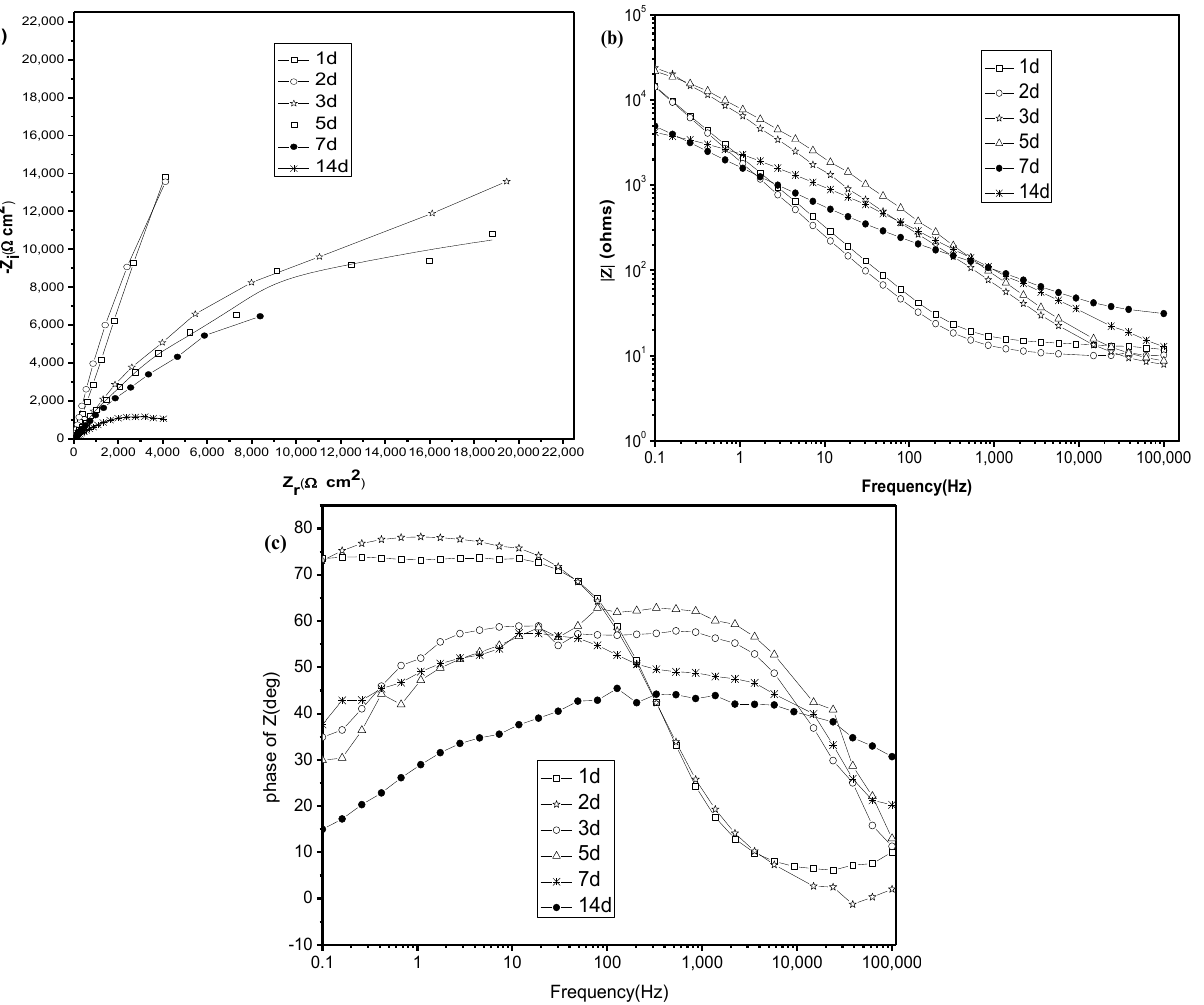
Figure 4. EIS of titanium immersed for different times in artificial saliva containing 5.0 g/L lactic acid. ( a ) Nyquist plots; ( b ) bode modulus diagrams; and ( c ) bode phase angle